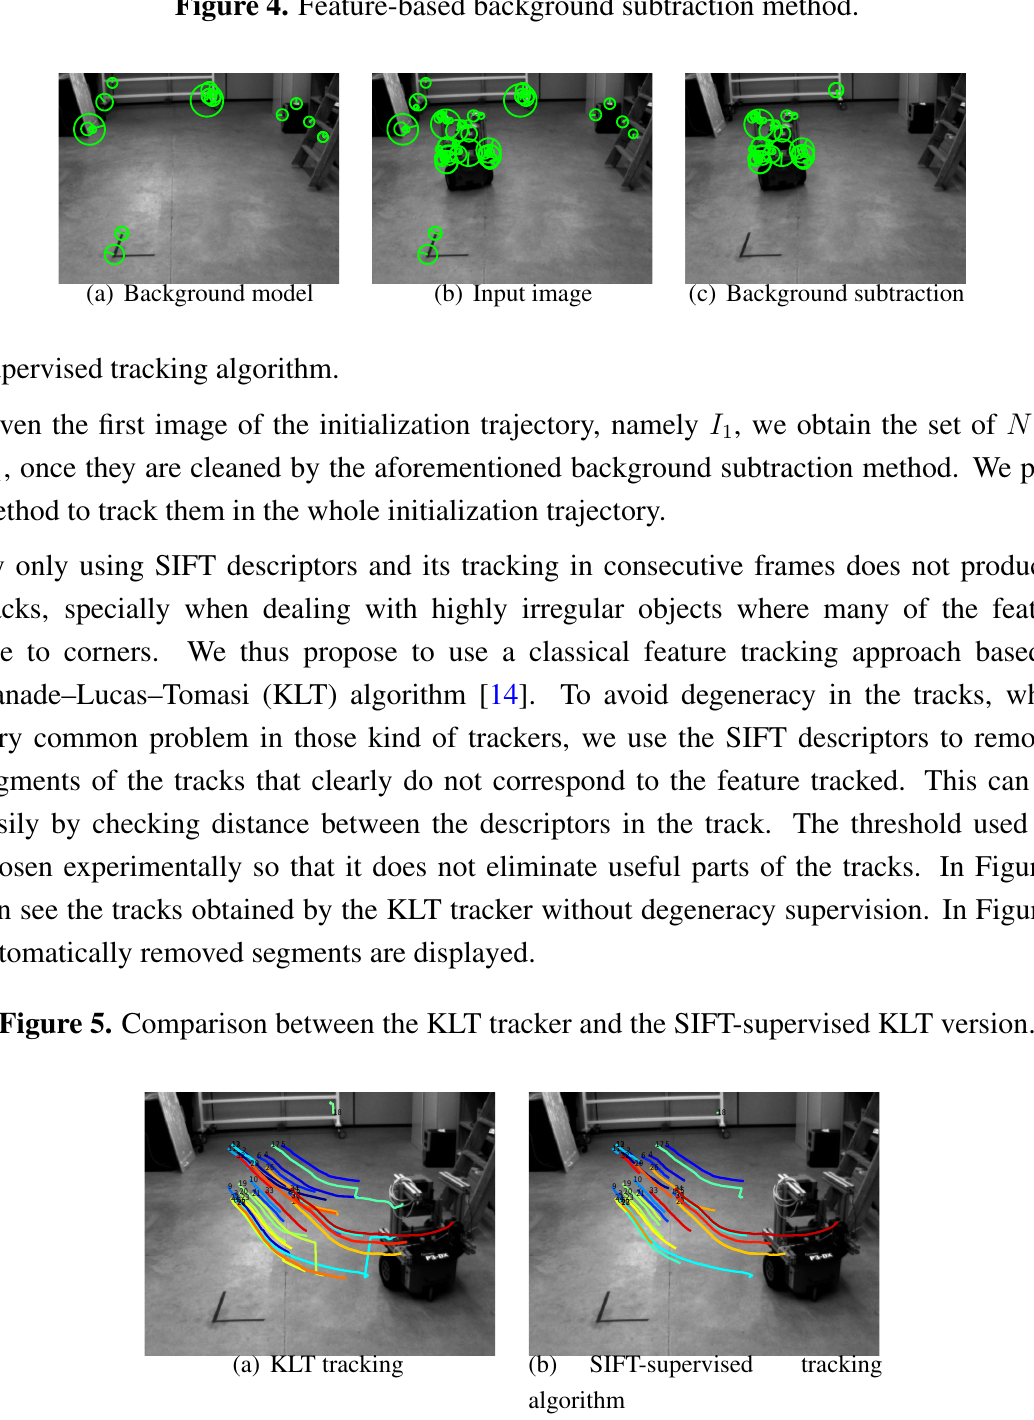
Figure 4. Feature-based background subtraction method.